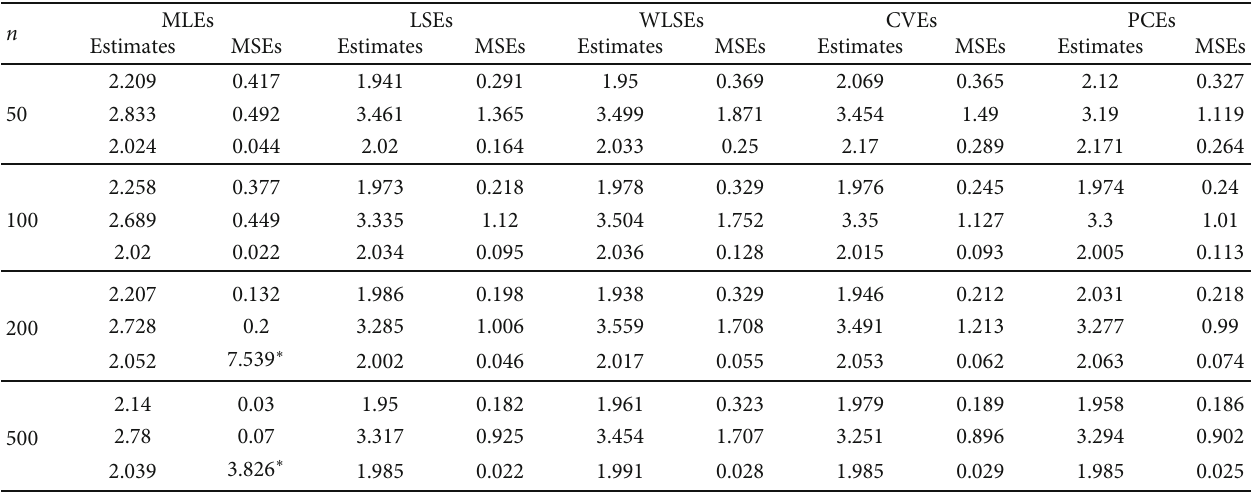
Table 3: Estimates and MSEs of parameters of TIIHLKwD for the Set2 ( a = 2, λ = 3, b = 2